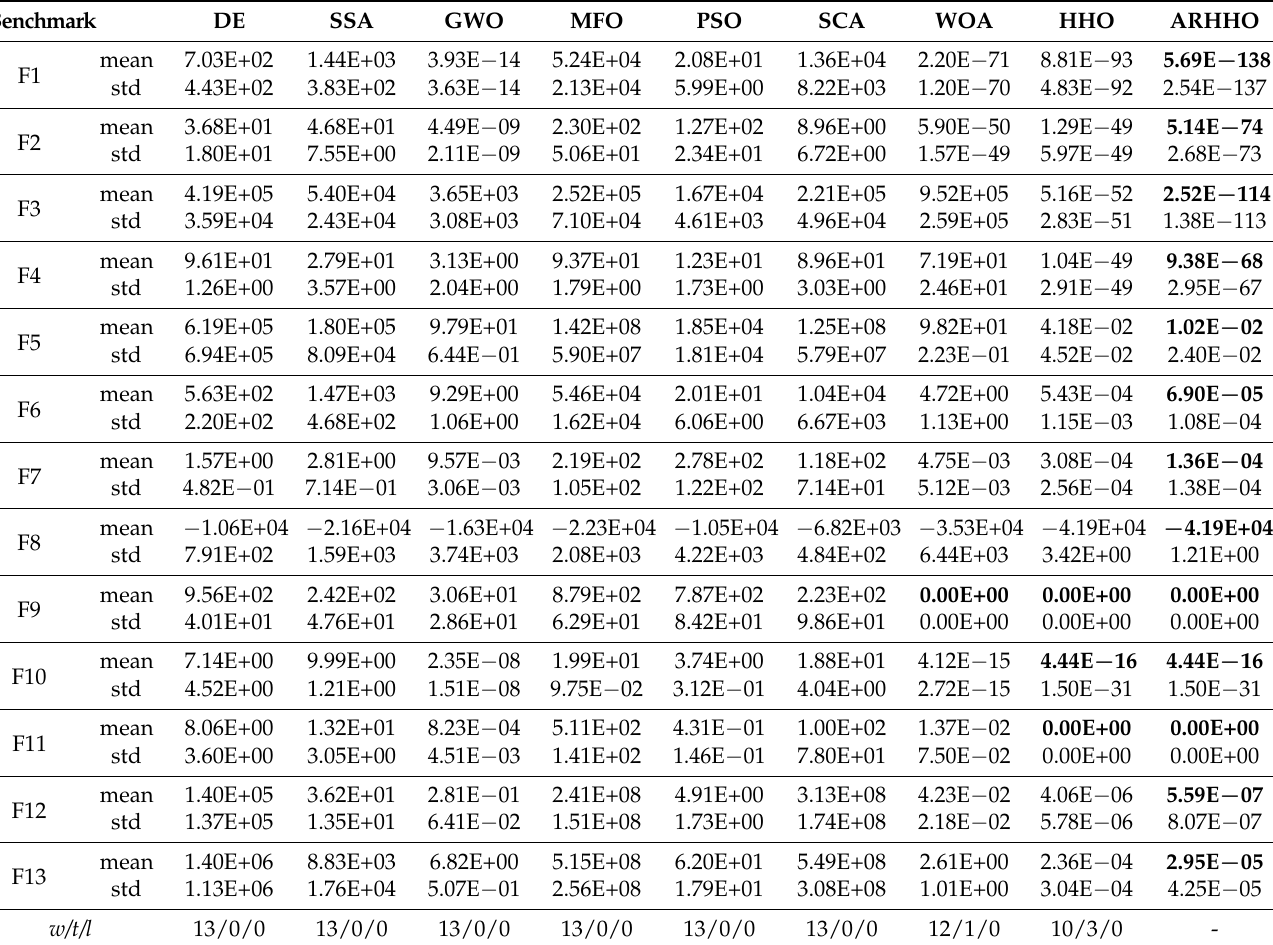
Table 3. Experimental results of benchmark functions F1~F13 in 100 dimensions.